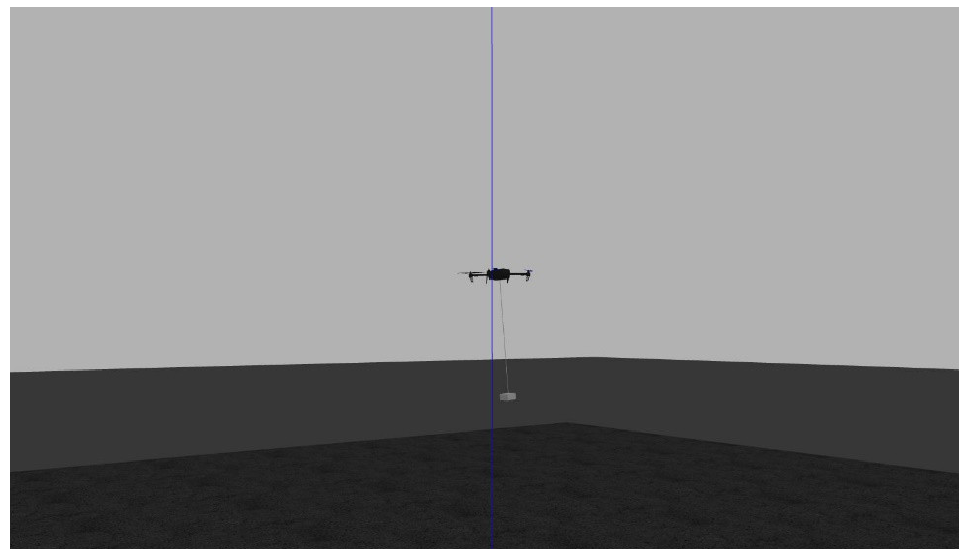
Figure 9. Quadrotor with the suspended load on the ground.